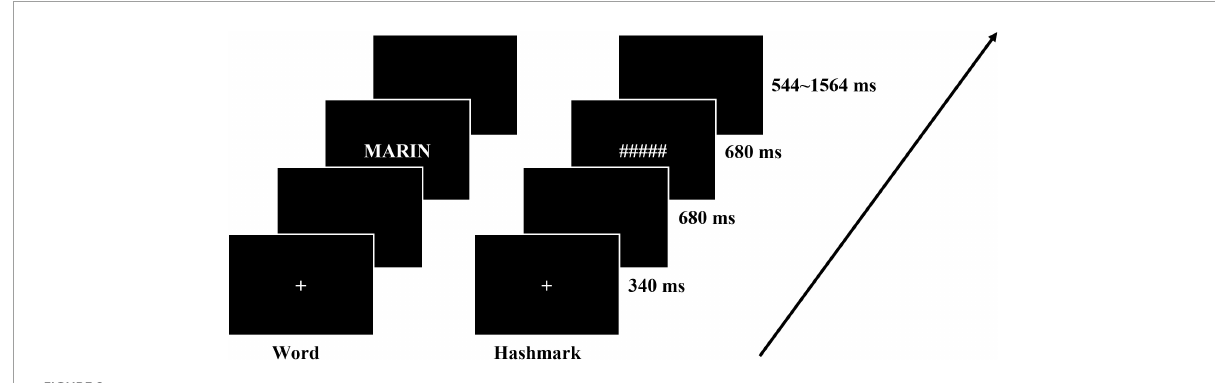
FIGURE2 Illustration of the experimental procedure and timing in the reading aloud task that was performed in the scanner.